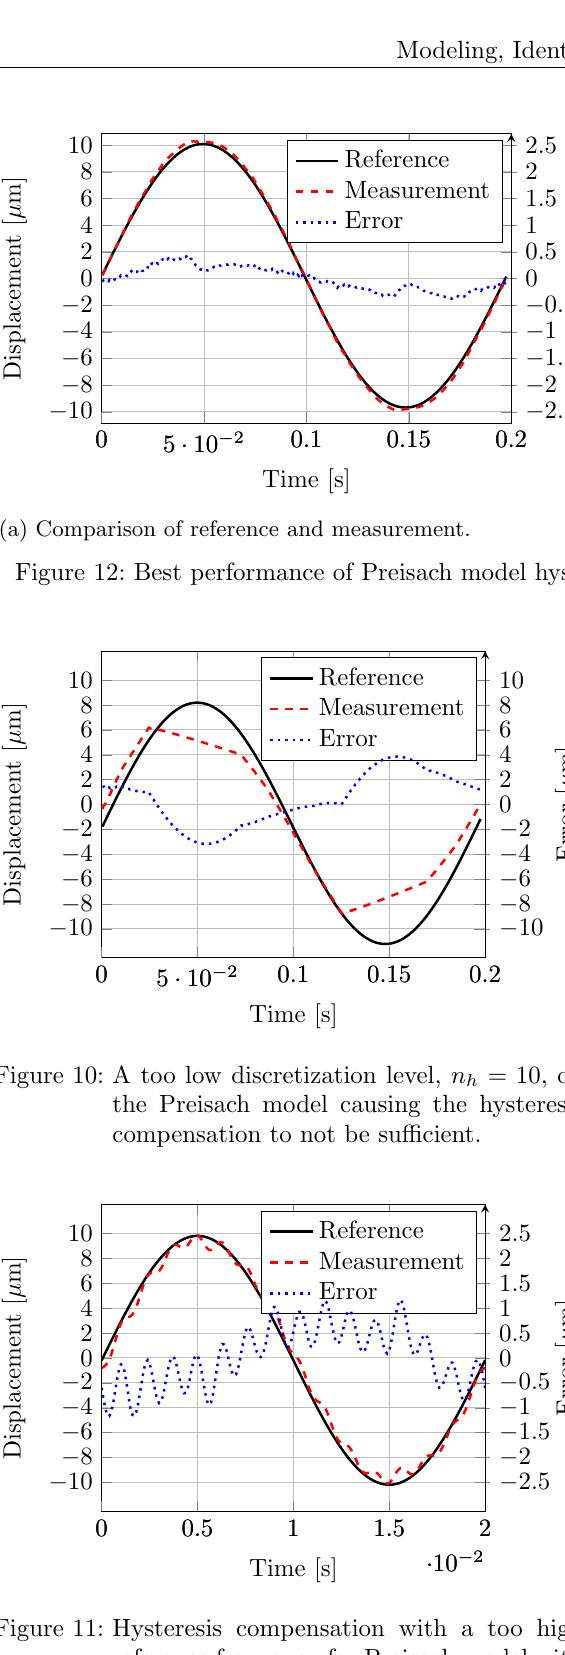
Figure 11: Hysteresis compensation with a too high reference frequency for Preisach model with discretization level n h = 100, where the vi- brations are caused by actuator dynamics.